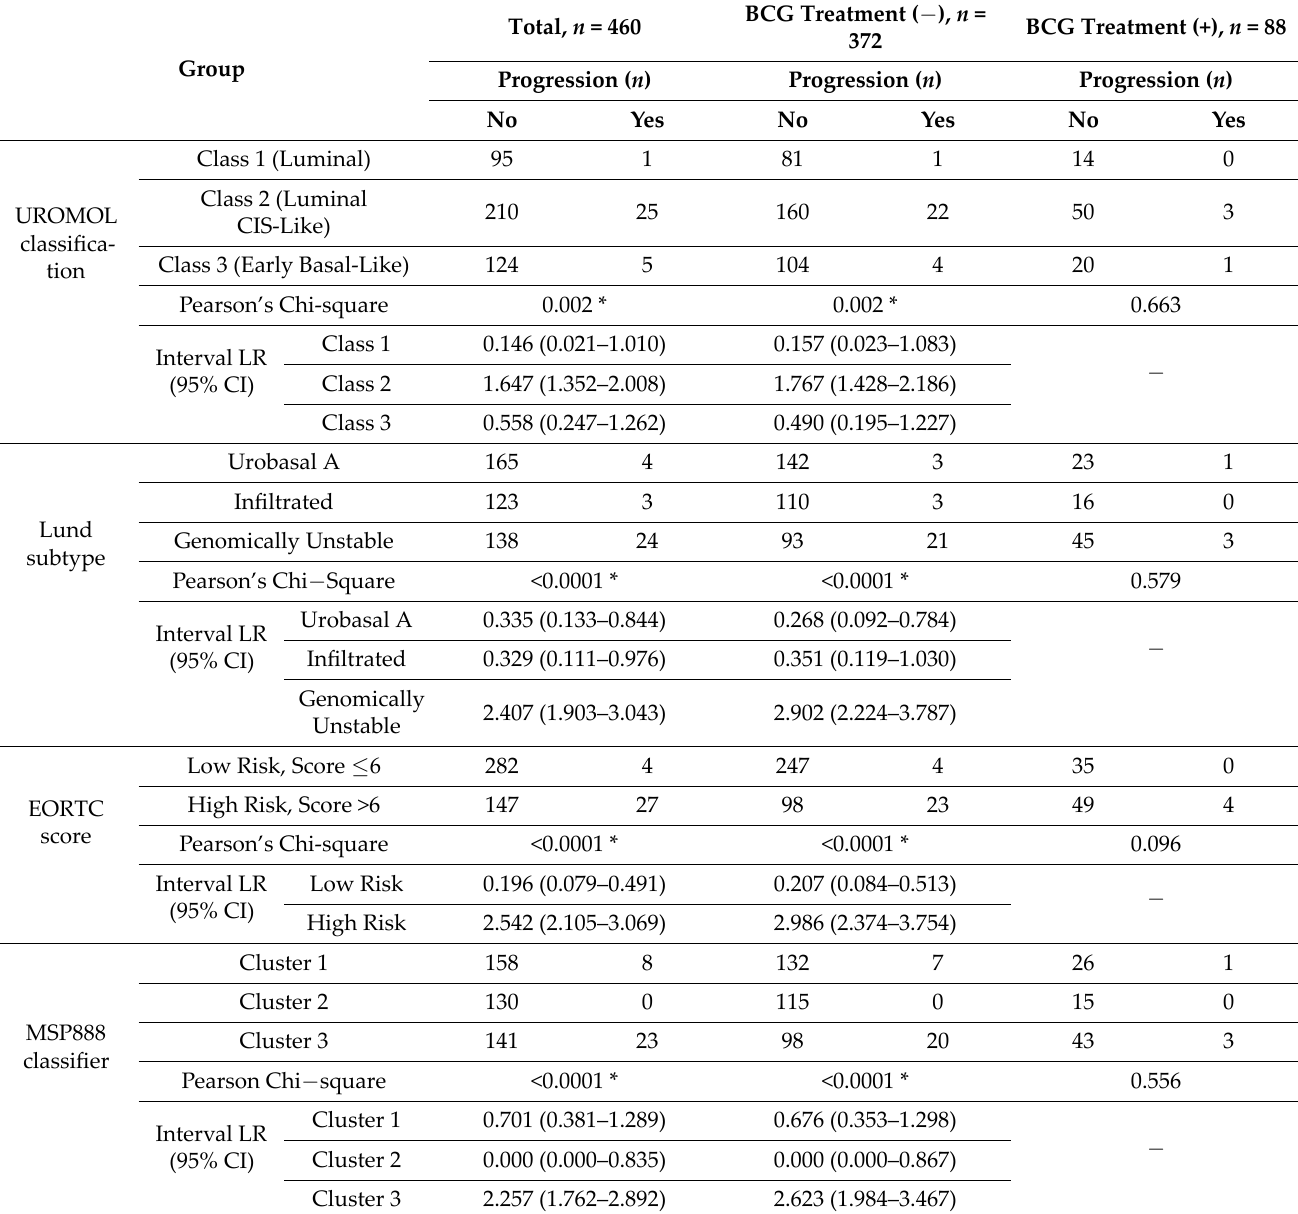
Table 4. Pearson’s Chi‑Square test for comparison of the different risk estimators in the UROMOL